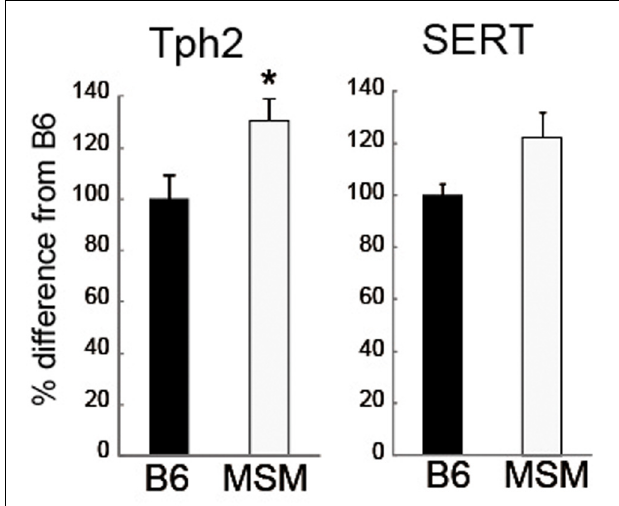
FIGURE 5 | mRNA expressions of tryptophan hydroxylase 2 ( Tph2 ) and 5-HT transporter ( SERT ) in the midbrain of MSM and B6. ∗ Significant strain difference between B6 and MSM ( p < 0 .